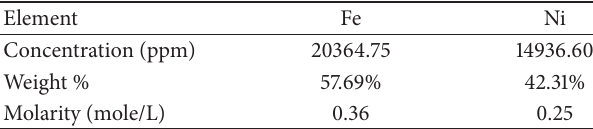
Table 2: Analysis of filtrate after detinning by ICP.